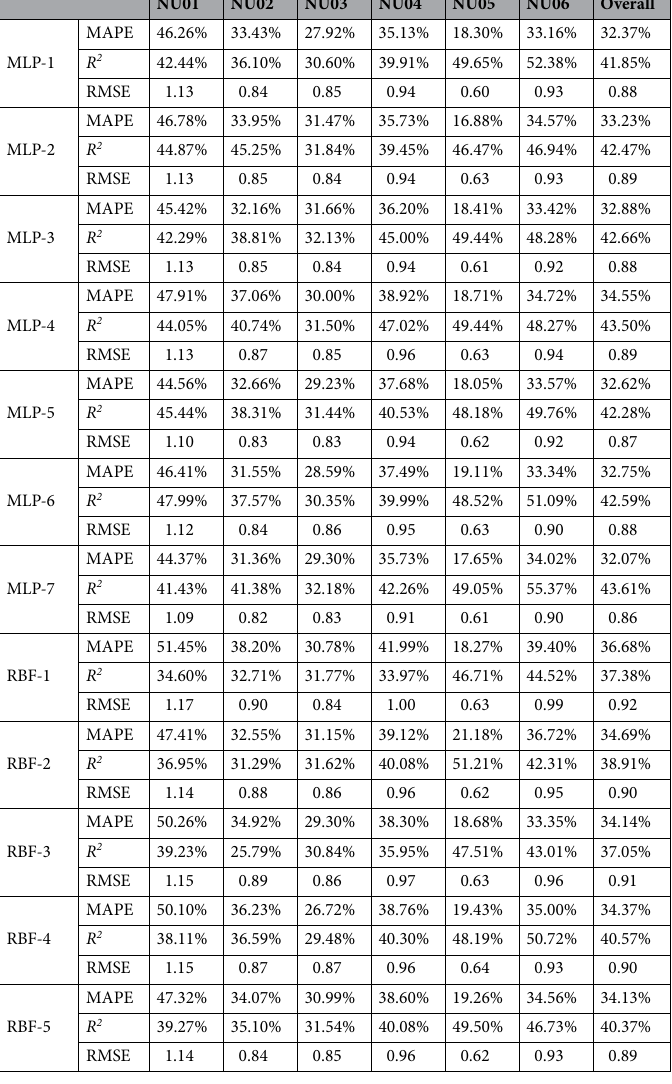
Table 6. Goodness of fit of the ANN